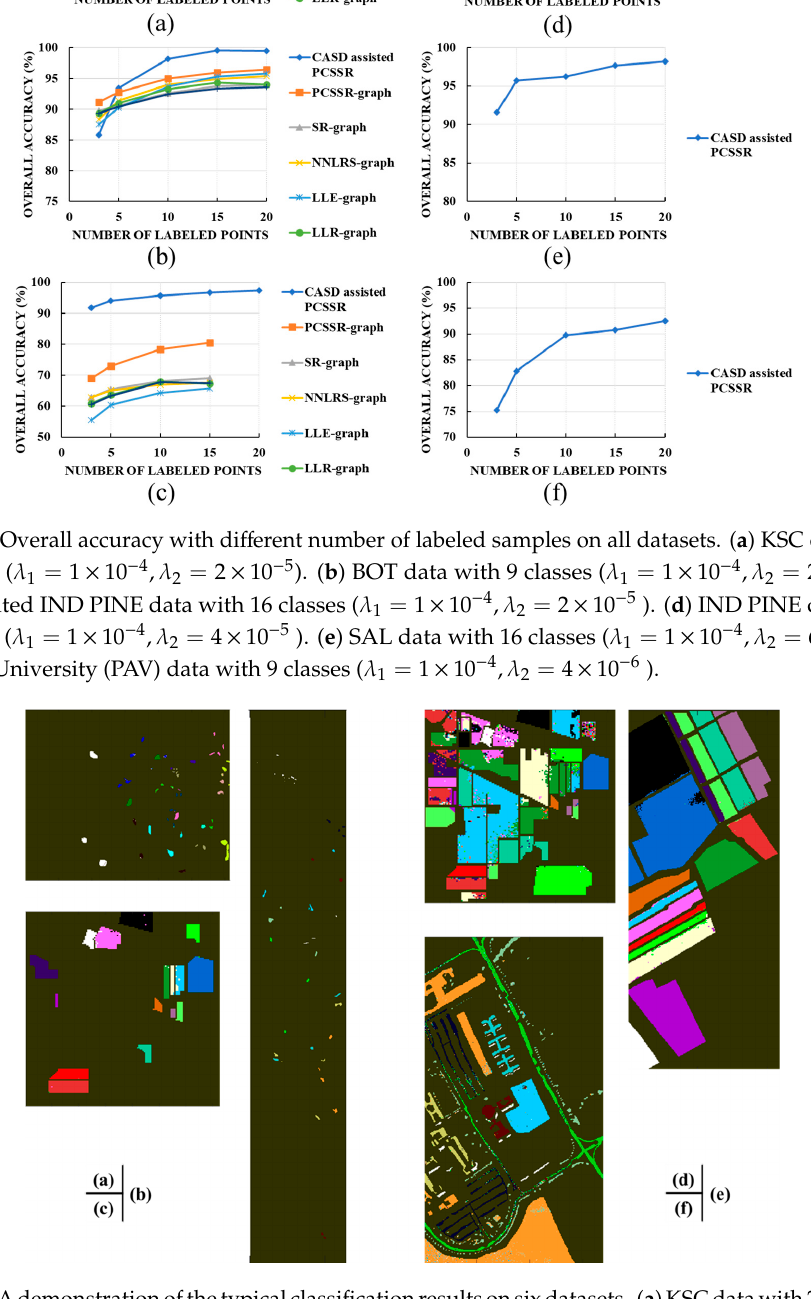
Figure 7. A demonstration of the typical classification results on six datasets. ( a ) KSC data with 20 labeled samples selected per class; overall accuracy (OA) = 96.16% ( λ 1 = 1 × 10 − 4 , λ 2 = 2 × 10 − 5 ). ( b ) BOT data with 20 labeled samples selected per class; OA = 99.93% ( λ 1 = 1 × 10 − 4 , λ 2 = 2 × 10 − 6 ). ( c ) Truncated IND PINE data with 15 labeled samples selected per class; OA = 98.36% ( λ 1 = 1 × 10 − 4 , λ 2 = 7 × 10 − 5 ). ( d )INDPINEdatawith20labeledsamplesselectedperclass; OA = 86.68%( λ 1 = 1 × 10 − 4 , λ 2 = 4 × 10 − 5 ). ( e ) SAL data with 20 labeled samples selected per class; OA = 98.72% ( λ 1 = 1 × 10 − 4 , λ 2 = 6 × 10 − 6 ). ( f ) PAV data with 20 labeled samples selected per class; OA = 92.68% ( λ 1 = 1 × 10 − 4 , λ 2 = 4 × 10 − 6